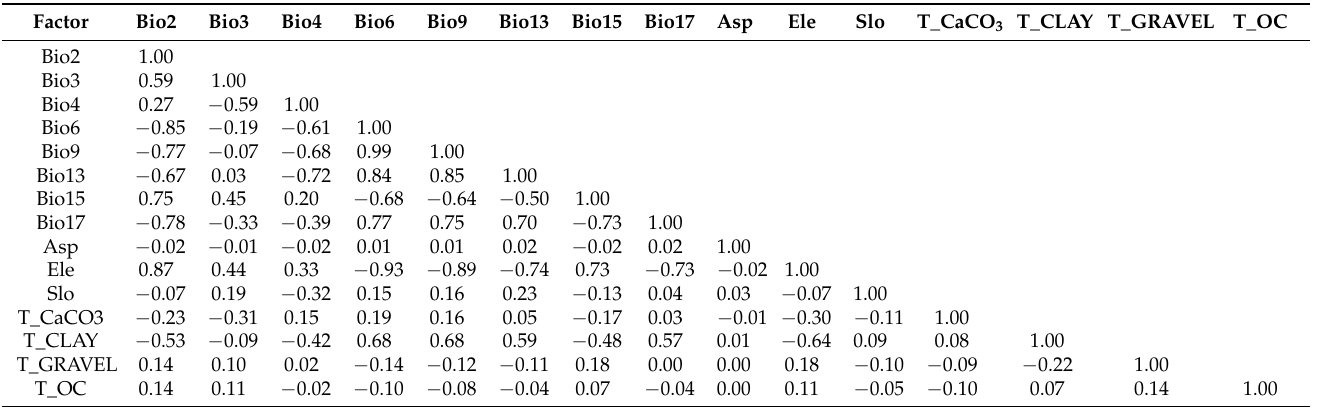
Table A1. Multi-collinearity test by utilizing correlations among climate variables for R. protistum . Factor